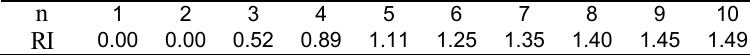
Table 2 – Random index values T аблица 2 – Значения случайного индекса Табела 2 – Вредности случајног индекса